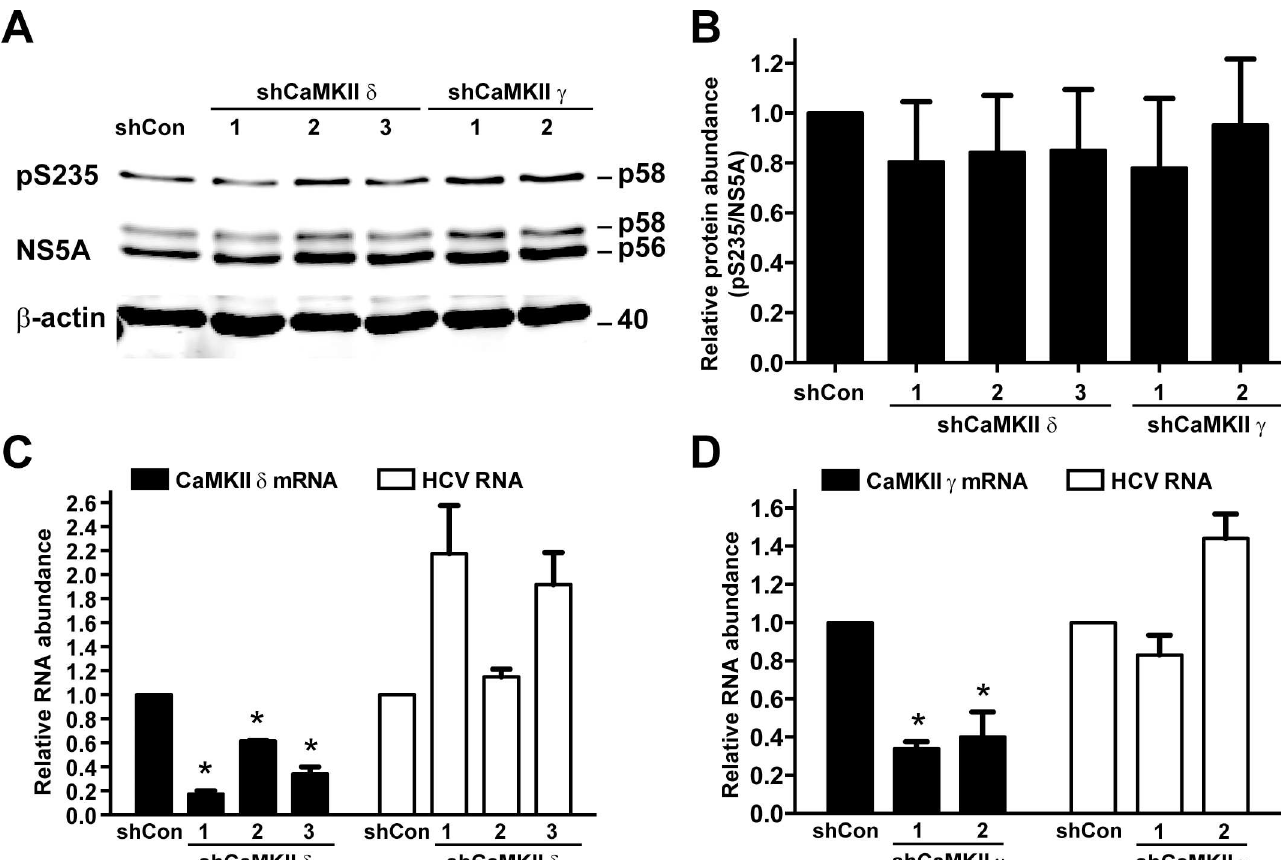
Fig 5. CaMKII γ or δ knockdown did not affect NS5A S235 phosphorylation or HCV RNA levels in the infected Huh7.5.1 cells. (A) Representative and summary (B) of the immunoblotting for NS5A and NS5A phosphorylation at S235 (pS235)in the HCV-infected Huh7.5.1cells upon CaMKII γ or δ knockdown. One day after the cells were infected with HCV (J6/JFH1), the cells were subjectedto small hairpinRNA (shRNA)- mediated CaMKII knockdown for 6 days prior to the immunoblotting analysis. Three and two shRNA sequenceswere used for CaMKII δ and γ Knockdown.Valuesare Mean ± SEM (n = 3). Asterisk indicatessignificancei.e. p < 0.05,t-test againstthe values in the non-targeted control cells (shCon). Protein abundance was quantified with the Li-Corscanner, adjustedfor the loadings(i.e. against β -actin)and normalizedwith the values in the control cells. (C and D) CaMKII mRNA and HCV RNA levels measuredwith quantitative RT-PCR in the HCV-infected Huh7.5.1cells with or without CaMKII knockdown. The experiments were done as those in a and b except that RNA was collected for the analysis. The GAPDH mRNA levels were analyzedas loadingcontrols. RelativeRNA abundance was normalized to the values of the control